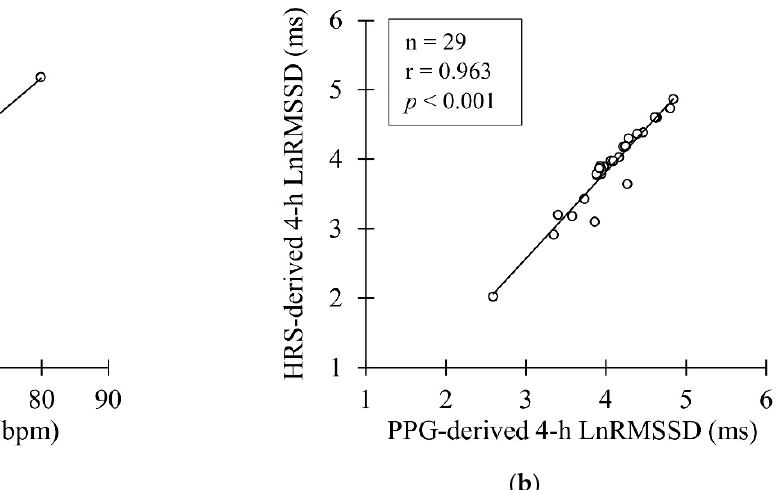
Figure 5. ( a ) Correlation between PPG- and HRS-derived nocturnal HR ( b ) Correlation between PPG and HRS-derived nocturnal LnRMSSD.